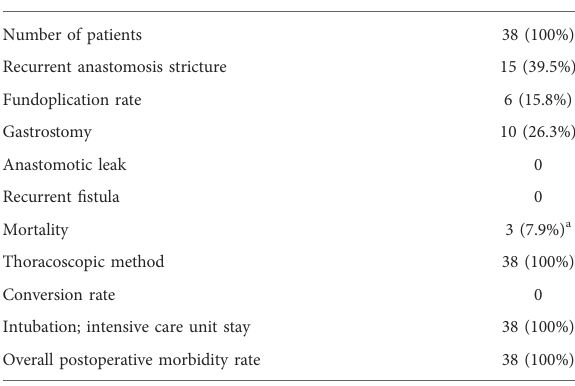
TABLE 7 Postoperative